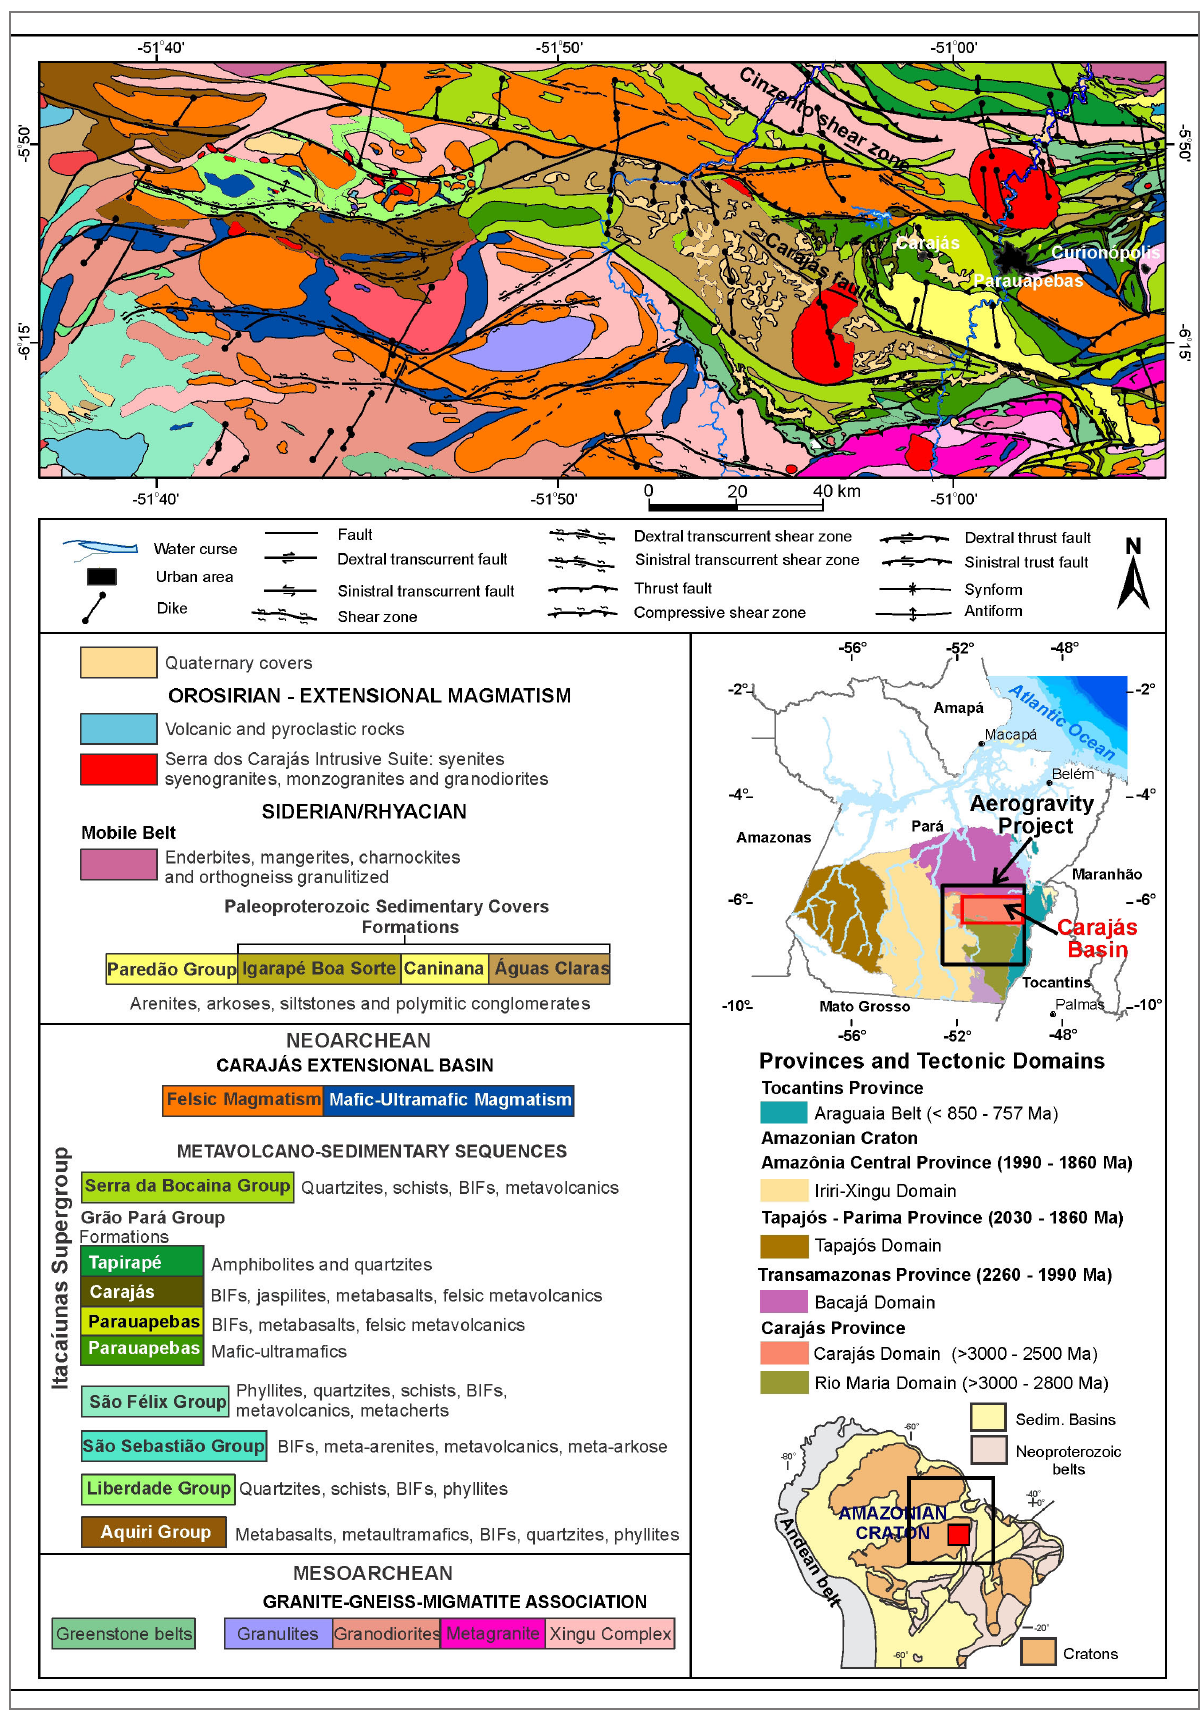
Figure 1. - Simplified geological map of the Carajás Basin and surroundings, Amazonian Craton, Northern Brazil, modified from Costa et al. (2016). The inset in the upper right corner shows the Amazonian Craton tectonic subdivision in the southern Pará State according to Vasquez et al.